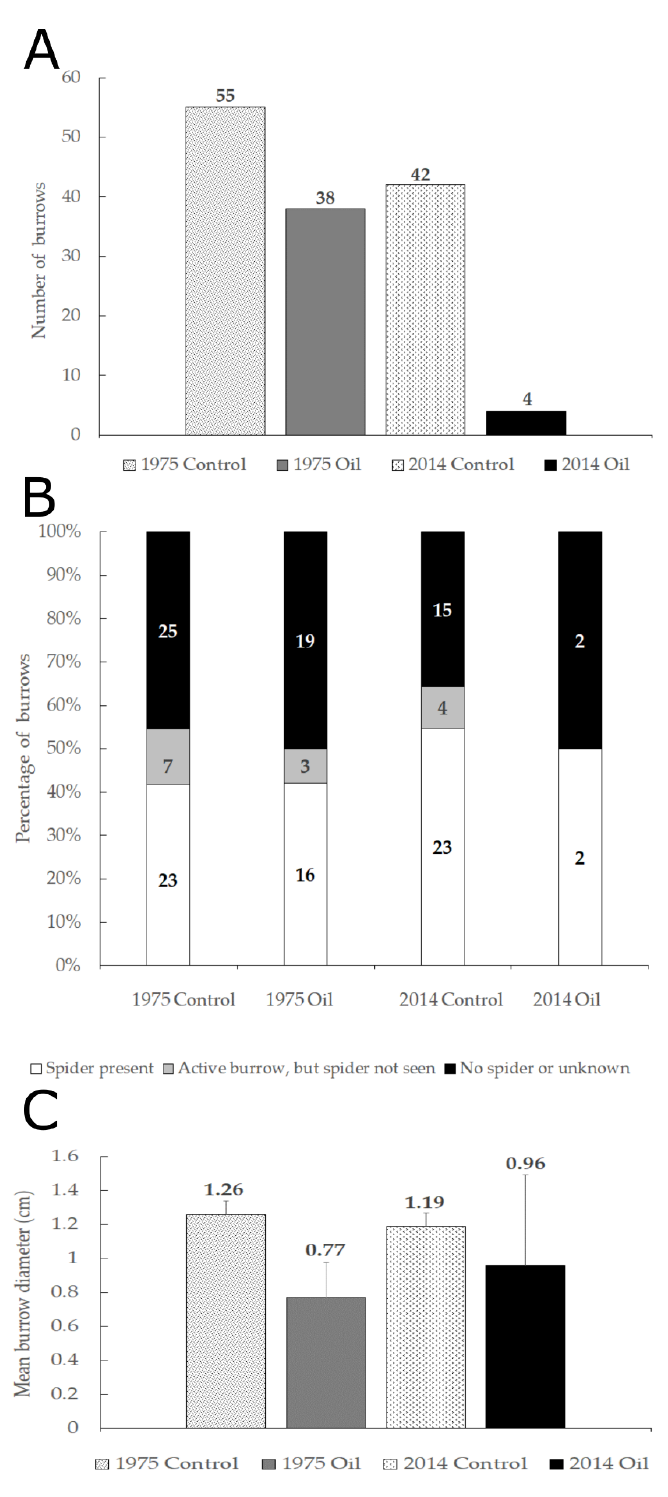
Figure 7. ( A ). Distribution of 139 Sahastata burrows observed in four plot types during the entire monitoring period. ( B ). Percentage of burrows with spiders (white), active burrows where spiders were not observed (grey), and with burrows that looks abandoned or where no spider was observed (black) in four plot types during the entire monitoring period. ( C ). Mean burrow opening diameter (centimeters) in the quadrat survey.